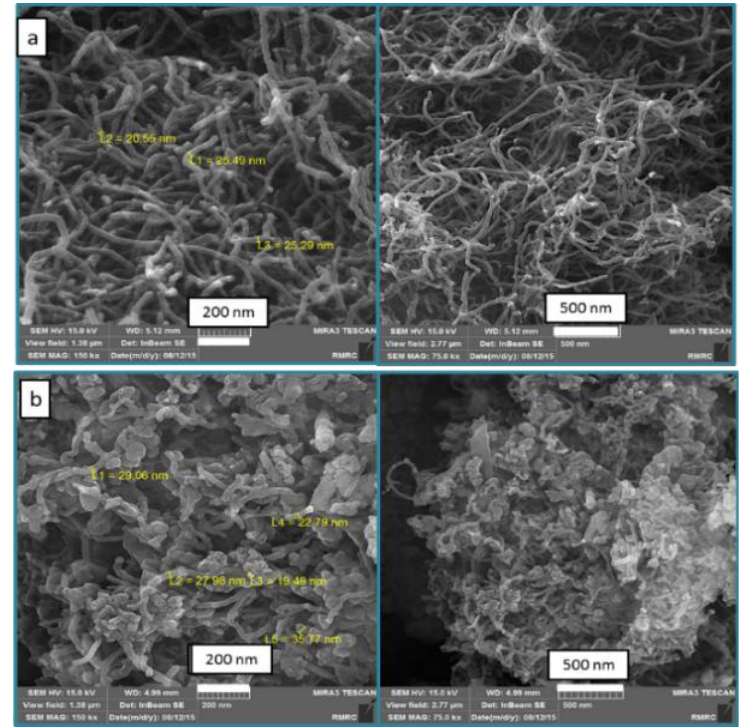
Fig. 1. FE-SEM images of (a) MWCNTs and (b)